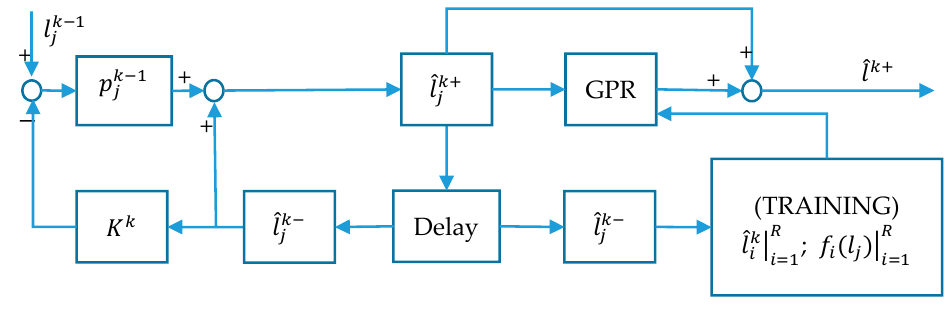
Figure 3. Block diagram of EKF – GPR algorithm.